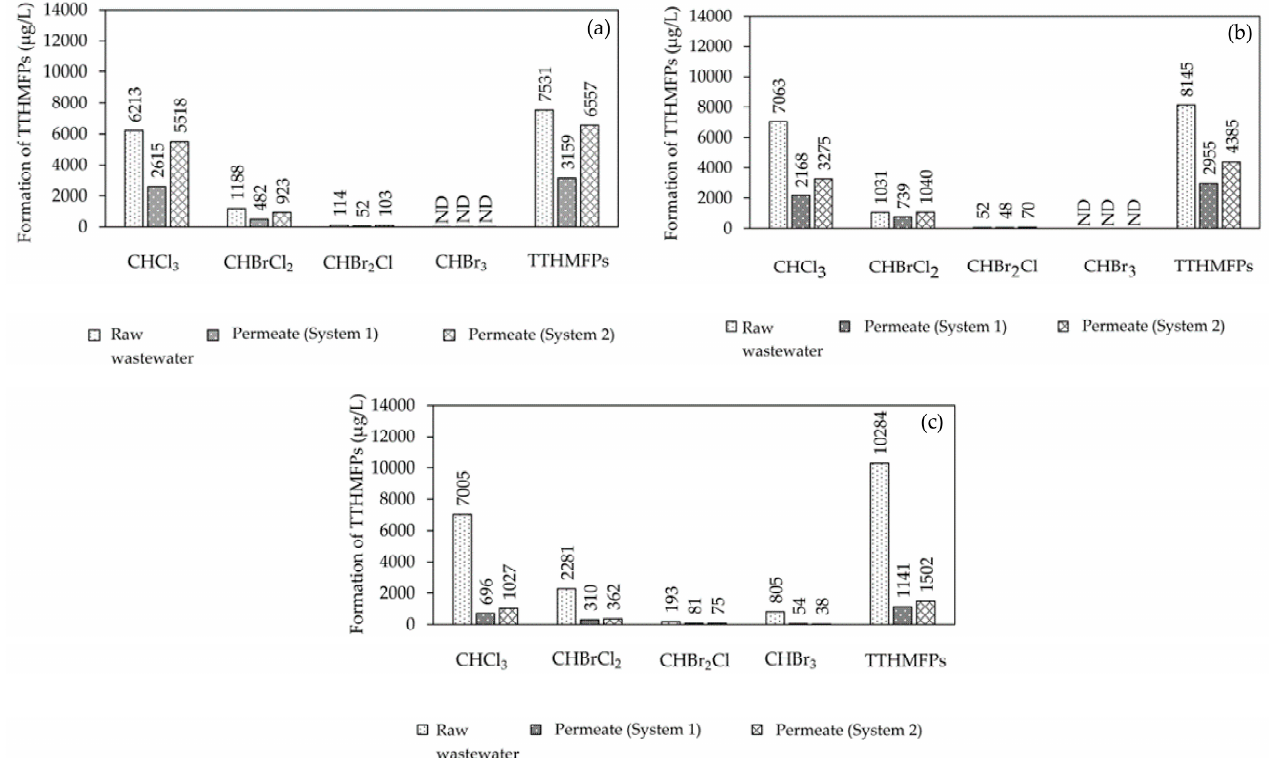
Figure 11. The formation of TTHMFPs at ( a ) SRT of 10 days, ( b ) SRT of 20 days and, ( c ) SRT of infinity.